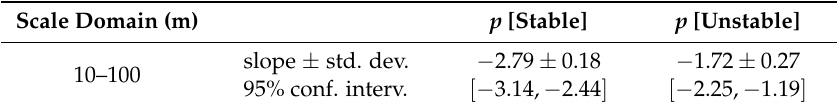
Table 2. Statistics on the spectral indexes p from 55 radiosonde profiles. The spectral indexes are estimated for the domain of scales 10–100 m. The mean p plus or minus the mean of standard deviations are indicated, as well as the average of the 95% confidence